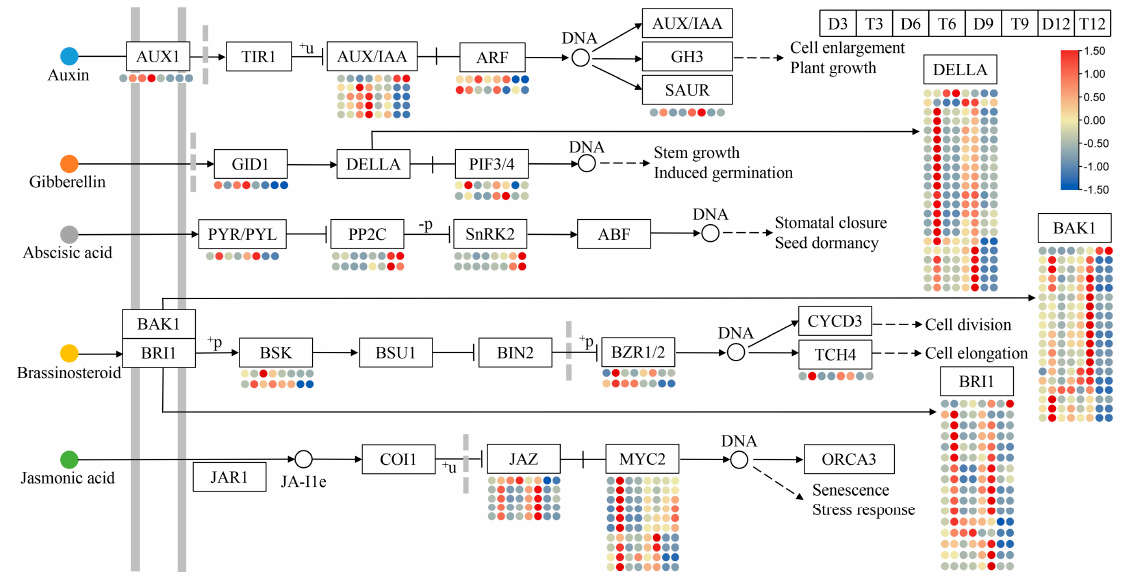
Figure 7. Heatmap showing the expression pro fi les of DEGs involved in plant hormone signal transduction in diploid and tetraploid P. hopeiensis . The color scale shows FPKM values, with blue colors indicating low values and red colors indicating high values.